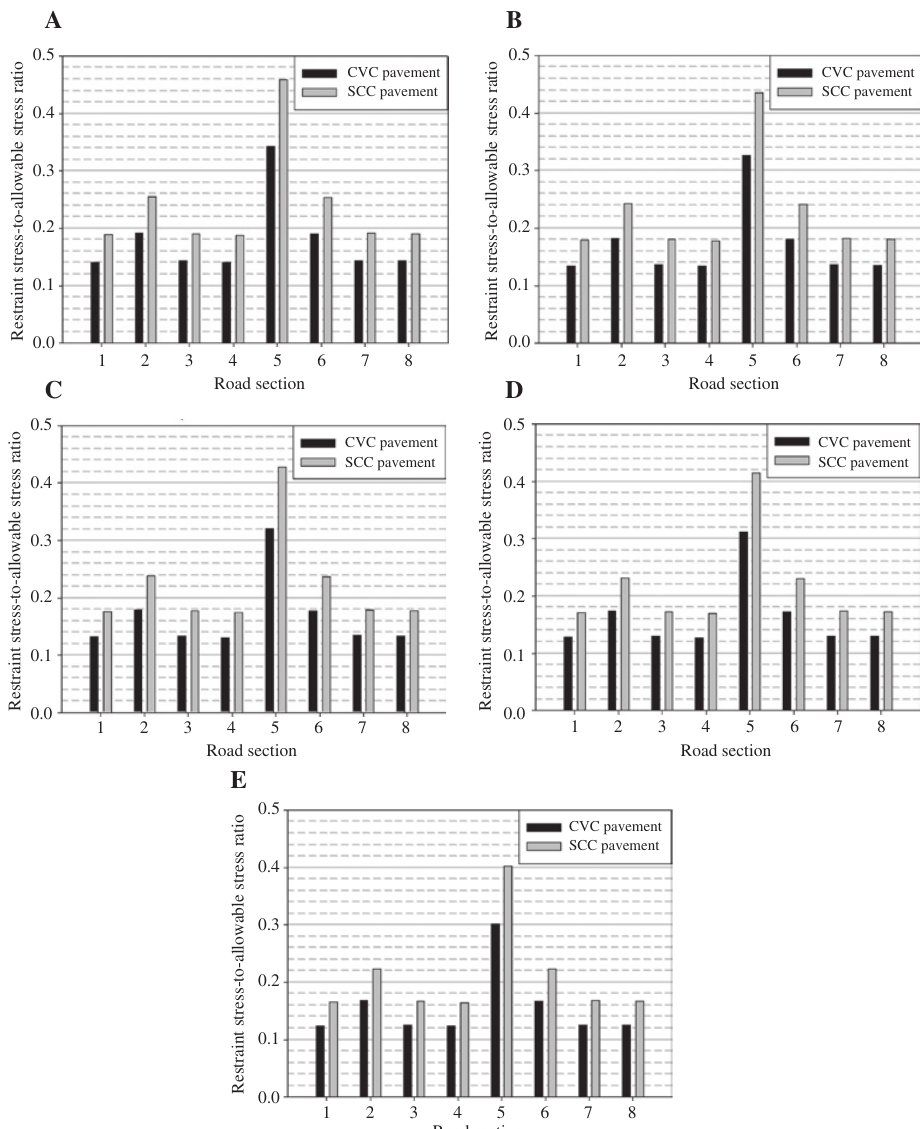
Figure 3: Restraint-to-allowable stress ratios of the CRCP sections in the presence of M16 bars. (A) Grade 10 concrete. (B) Grade 20 concrete. (C) Grade 30 and 40 concrete. (D) Grade 50 concrete. (E) Grade 60